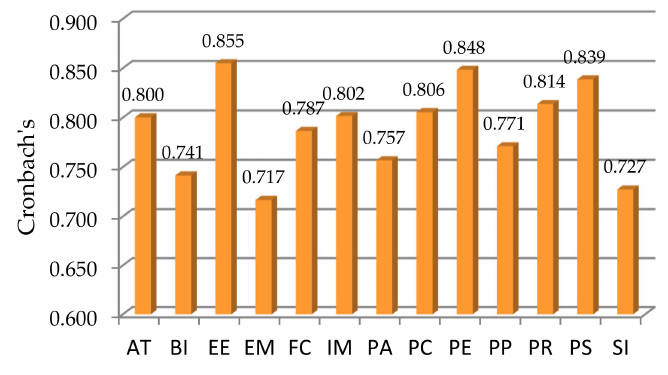
Figure 5. Cronbach’s alpha.